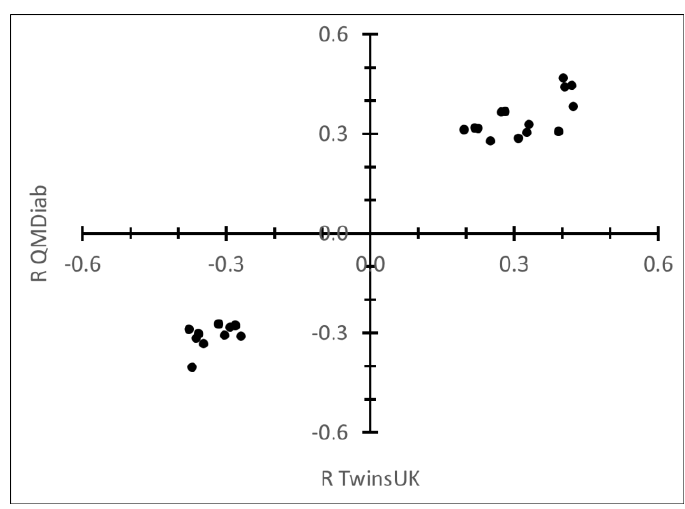
Figure 3. Consistency of the association between glycan traits and C-reactive protein (CRP) levels in TwinsUK and QMDiab. Correlation coefficients for TwinsUK and QMDiab are shown.